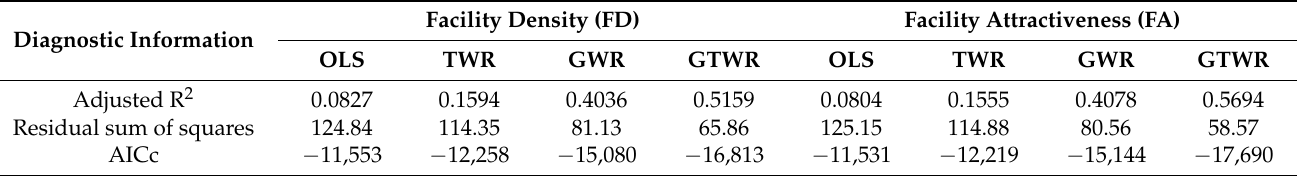
Table 3. Global diagnostic information for the estimation with FDs and FAs under various regression frameworks. Diagnostic